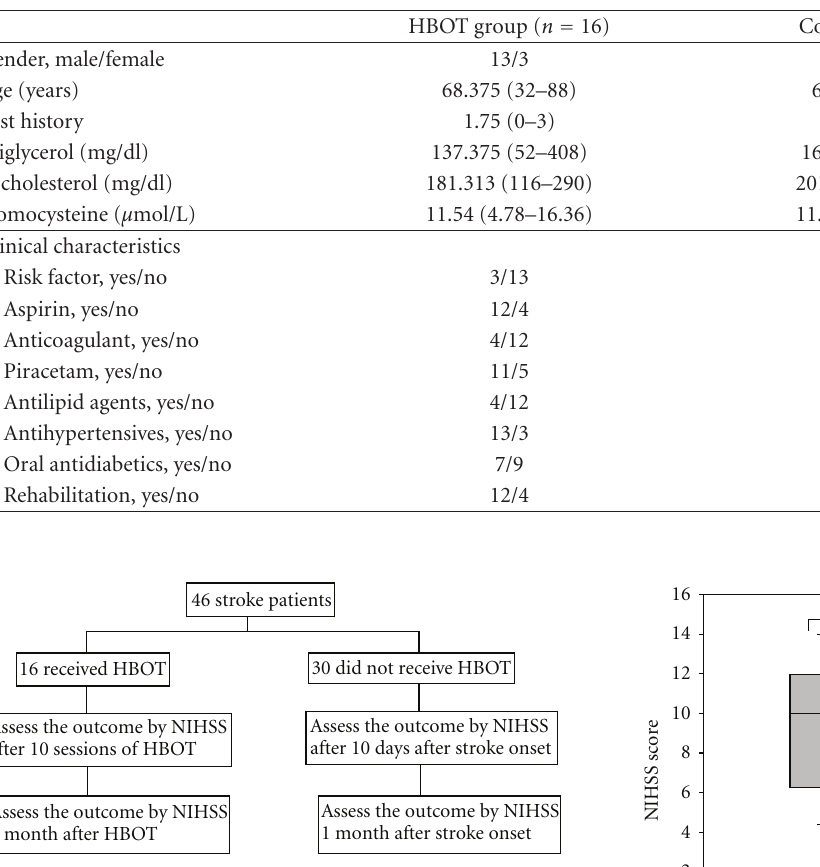
Table 1: Baseline characteristics of the study participants.